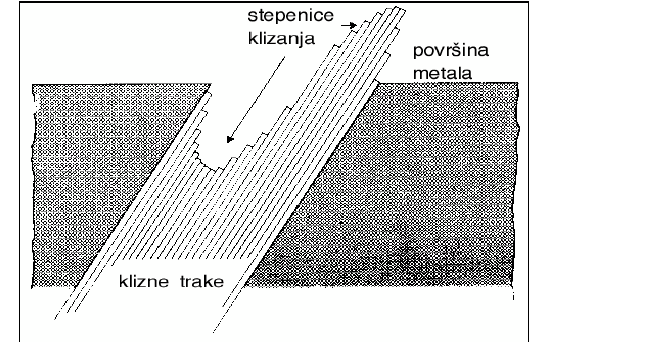
Figure 22 – The mechanism of creation of slip steps on the surface of metal